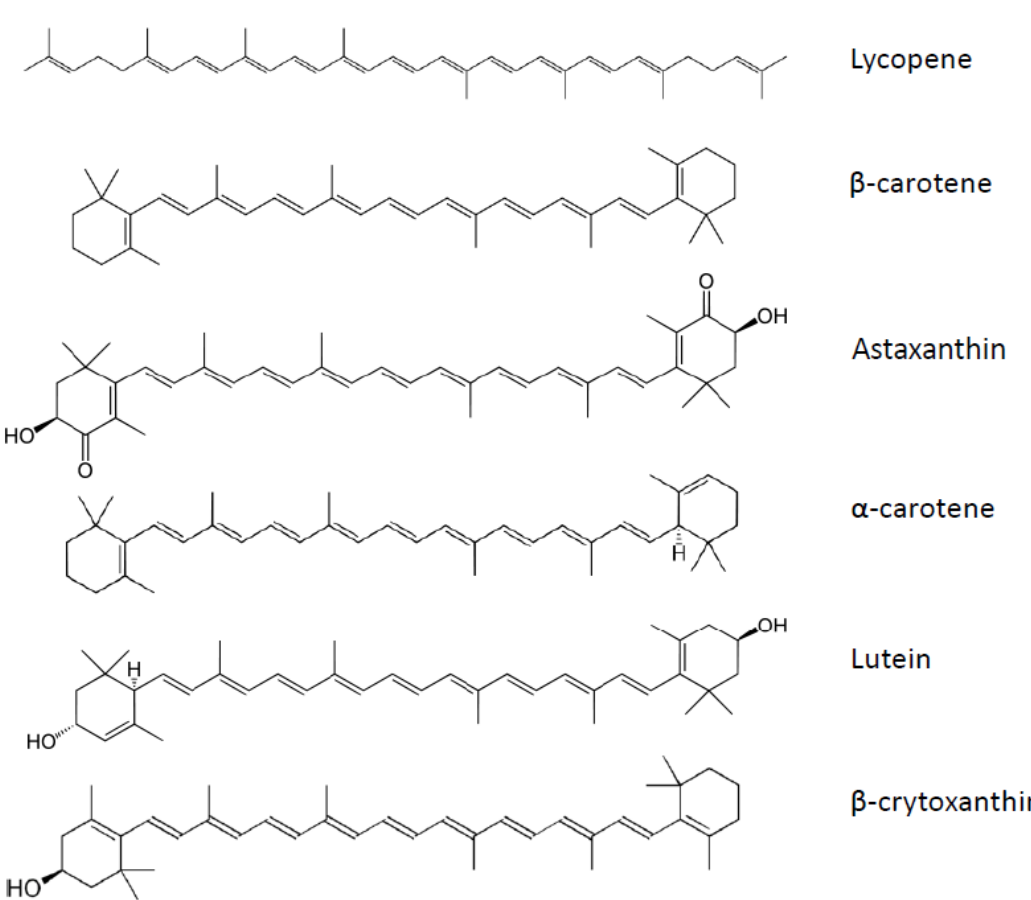
Figure 5. Carotenoids